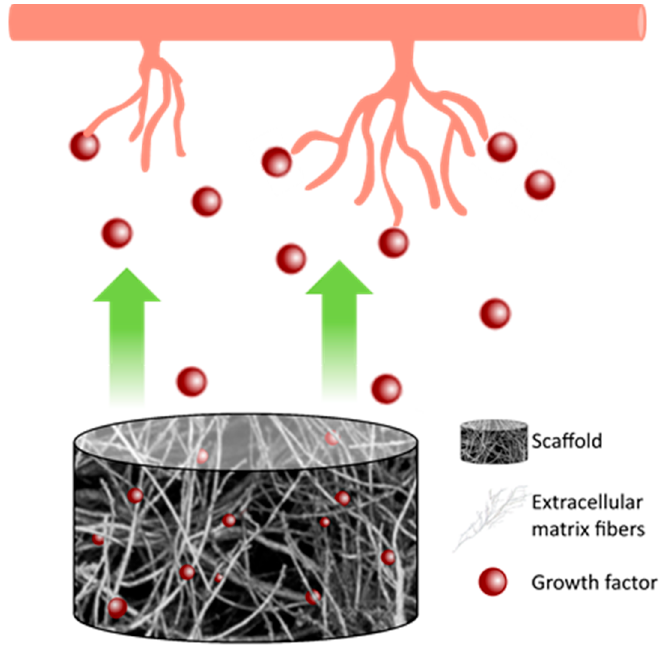
Figure 3. Hydrogel’s release of growth factors stimulates new capillary formation.